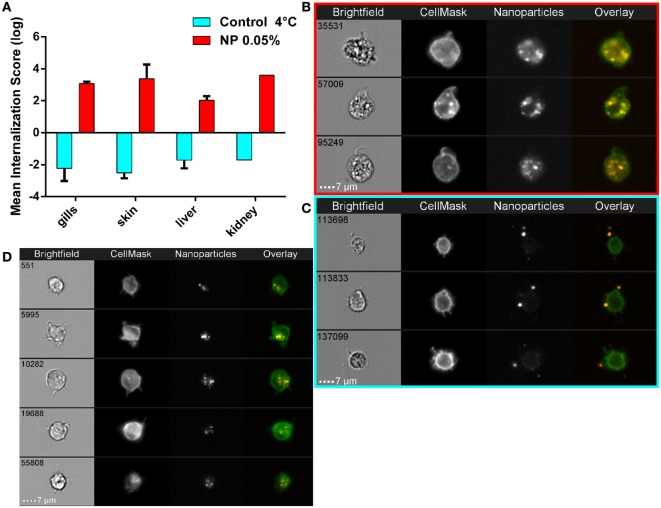
Active nanoparticles (NPs) internalization in cells of mucosae, kidneys, and liver. (A) NP internalization score, assessed by imaging in flow, in dissected organs from adult zebrafish exposed to 0.05% red fluorescent NPs (red histograms). As a negative control for internalization (blue histograms), PLA-NPs were added at 4°C just before acquisition on the cell suspension from fish unexposed to NP. Whereas most NPs are found at or outside the cell membrane in the negative controls (internalization scores <−1), a high majority of NPs is detected inside the cells of NP-treated fish (internalization scores >2) in all analyzed organs. (B–D) Representative images of NPs in kidney (B,C) or gill (D) cell suspensions, from NP-exposed fish (B,D) or control conditions (C), which display membrane processes reminiscent of dendrites. Total number of analyzed cells (NP 0.05%/4°C control): gills (three independent acquisitions) 1312/4355, skin (two independent acquisitions) 345/4185, liver (two independent acquisitions) 1431/2651, and kidney (one acquisition) 117/3180. One fish per acquisition. Error bars: SD.